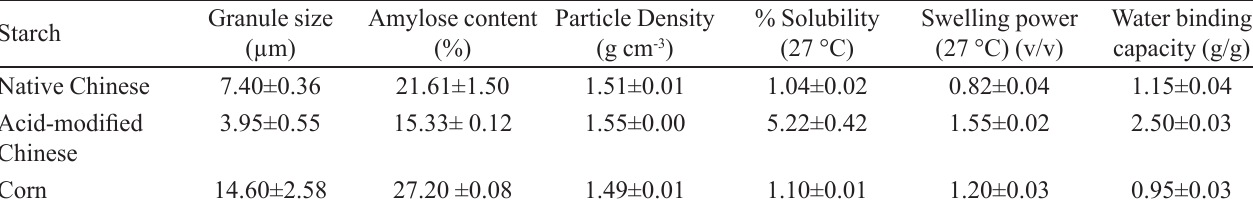
TABLE I - Physicochemical properties of the starches (Mean ± SD, n = 4) Starch